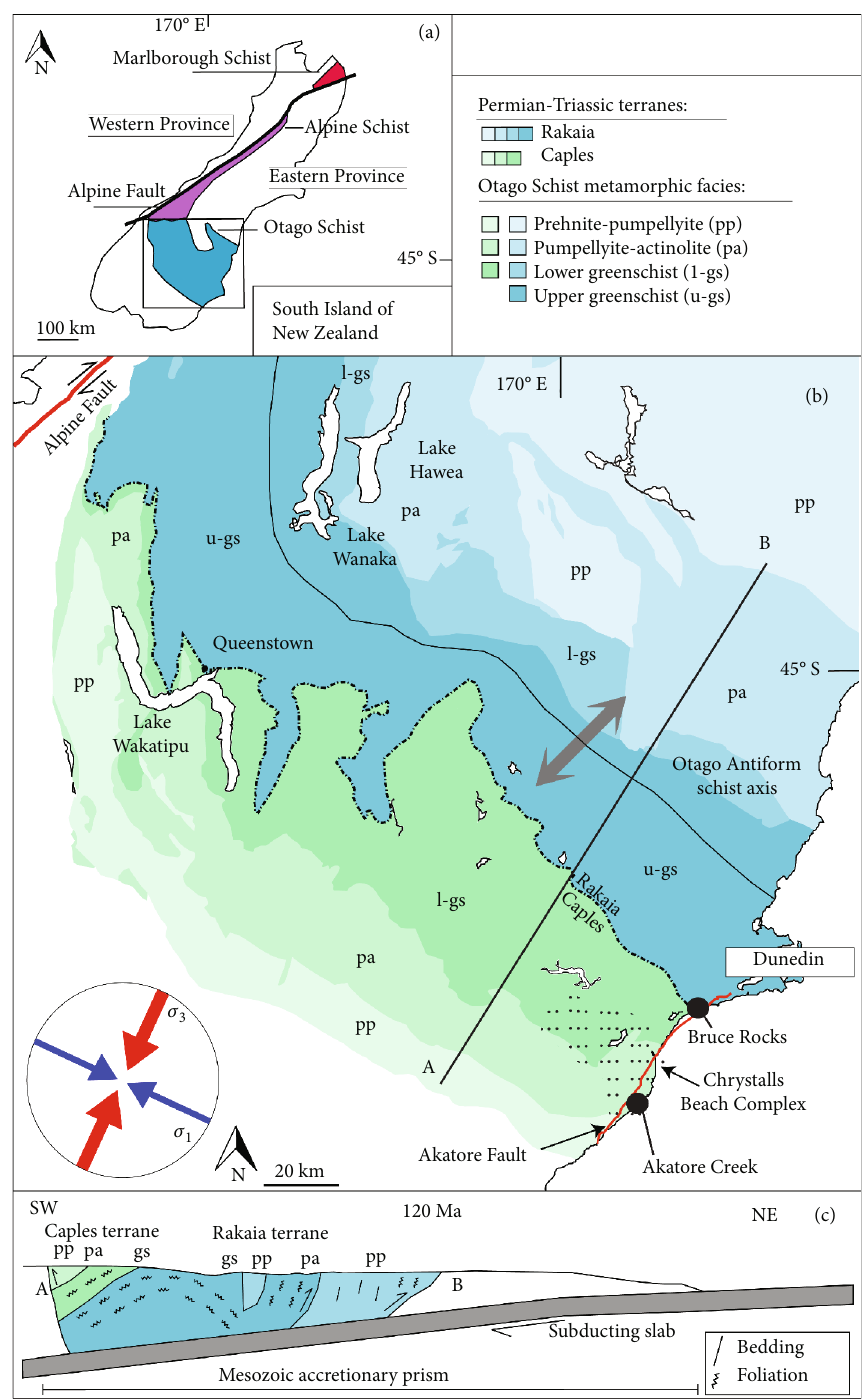
Figure 1: Geological setting of the fi eld areas. (a) Simpli fi ed map of the South Island of New Zealand showing the Otago Schist and Alpine Schist. (b) Map showing the distribution of metamorphic facies in the Otago Schist, metamorphic terranes, the Chrystalls Beach Complex, and the Akatore Fault, together with the fi eld locations at Akatore Creek and Bruce Rocks. Stereoplot in the bottom-left corner illustrates the modern-day strike-slip stress fi eld in Otago and Canterbury as reconstructed from earthquake focal mechanisms and borehole breakout data (after [39] and [41]). (c) Simpli fi ed cross-section through the Otago Schist showing the regional scale antiformal structure. Schematic relationship to the Mesozoic accretionary prism is also shown